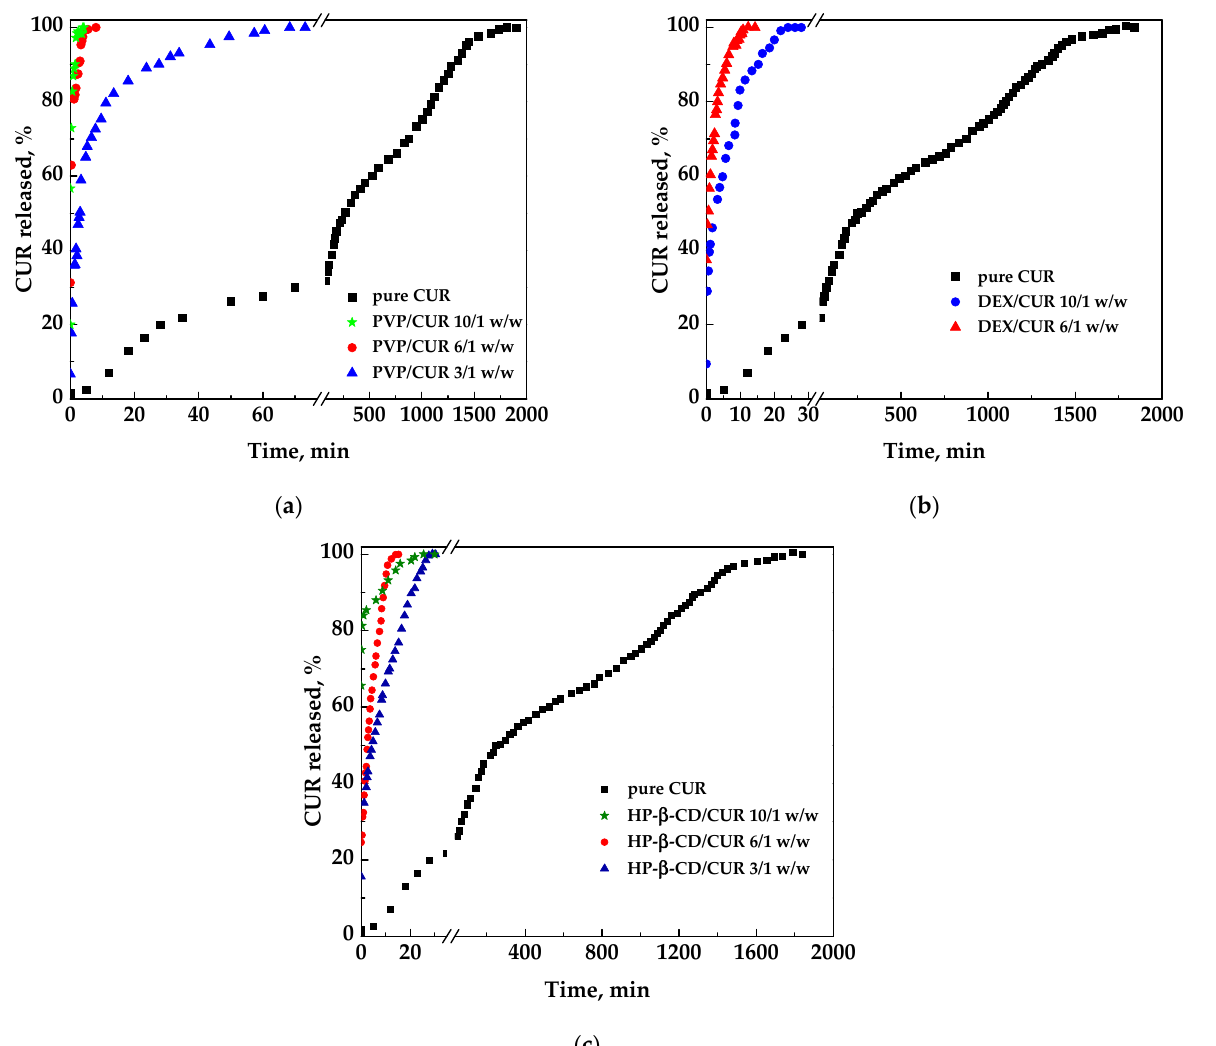
The dissolution profiles reported in Figure 7 were measured on curcumin in pure form or released from different coprecipitates to highlight the influence of the various carriers on the CUR dissolution rate.